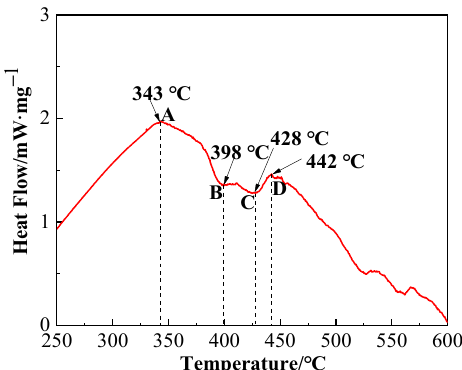
Figure 6. Differential scanning calorimetry (DSC) graph of the brazing filler glass. Table 2. Description of feature points in Figure 6.